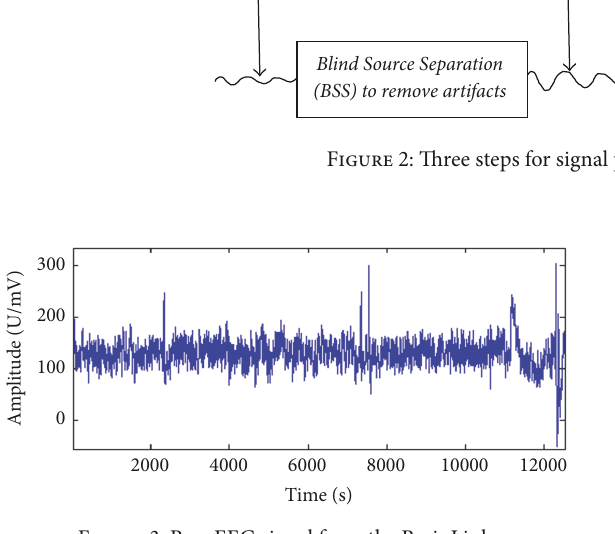
Figure 3: Raw EEG signal from the